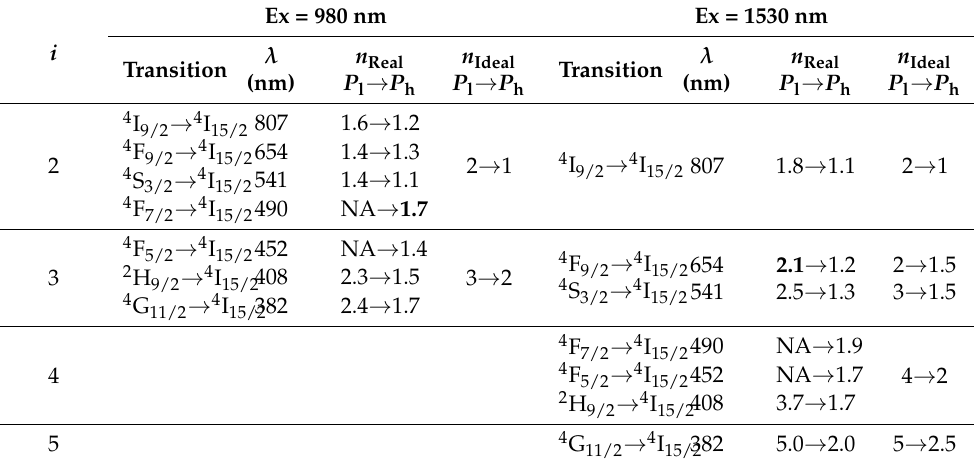
Table 1. Summarized power dependences data of the 10Er sample, where i stands for the photon number required for populating the UCL energy level; λ is the emission peak; and P l and P h represent low pumping and high pumping,